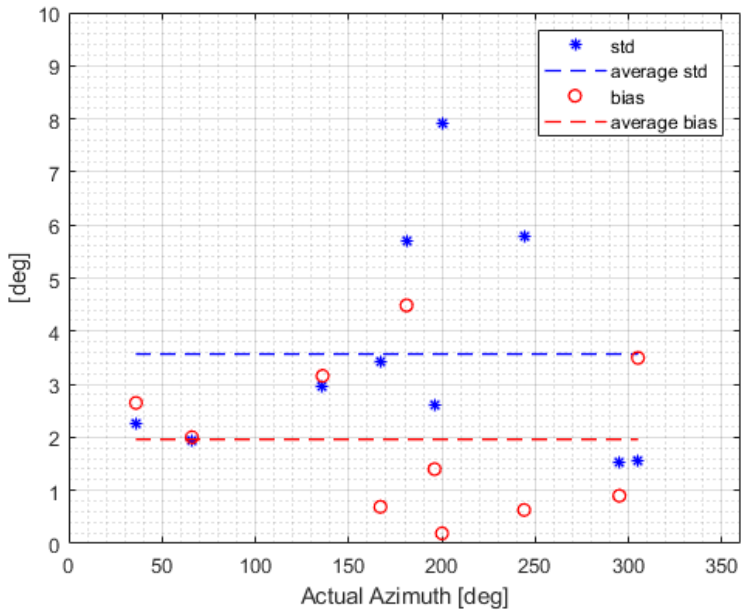
Figure 8. AOA standard deviation and bias versus the actual azimuth.